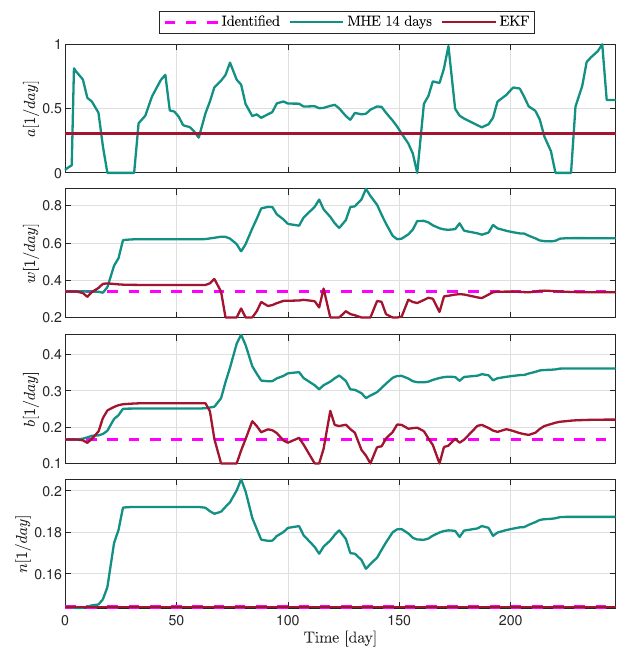
Figure 6. Estimated parameters of PLD5